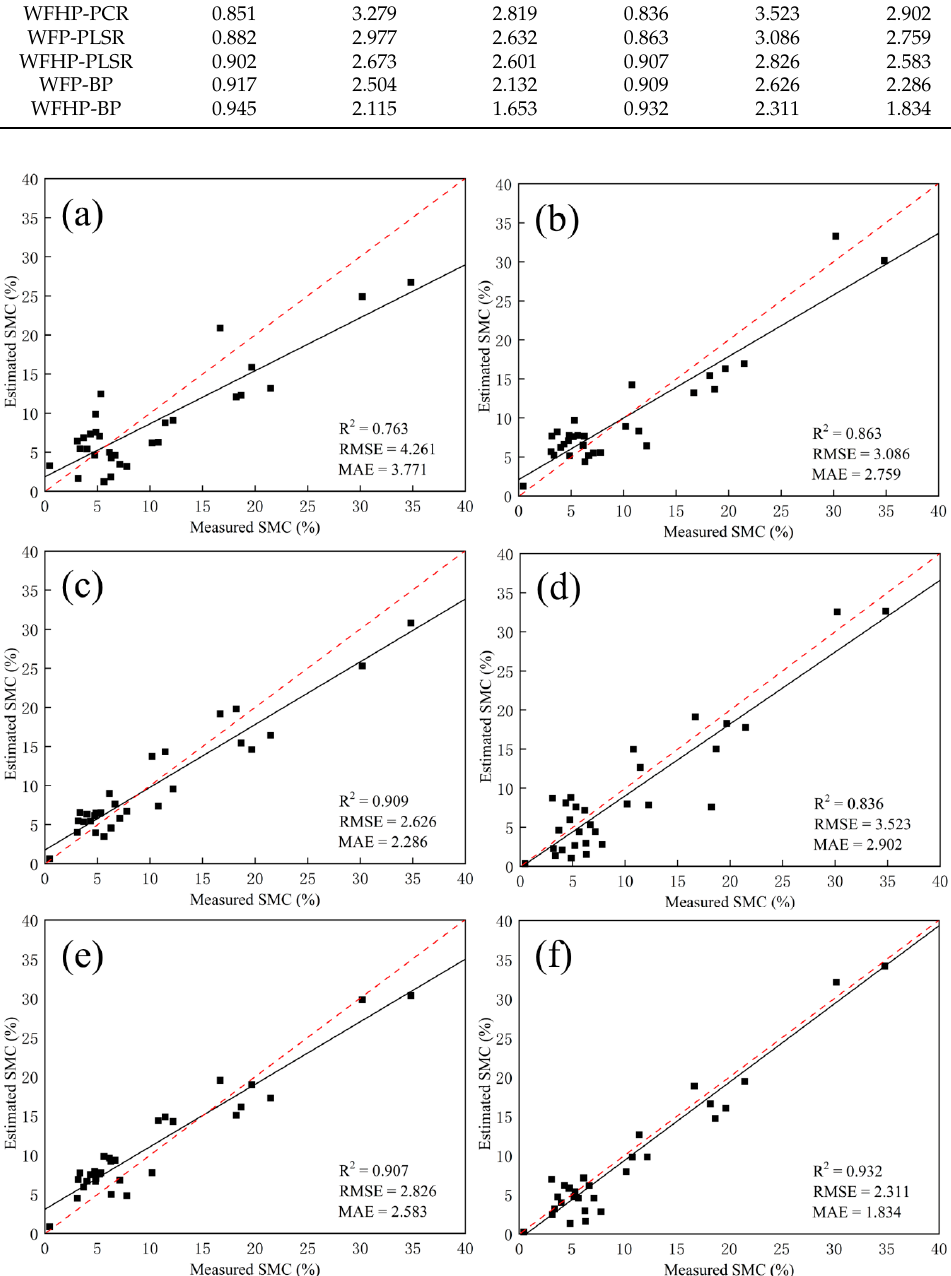
Figure 8. The comparison of measured and estimated SMC: ( a ) WFP-PCR; ( b ) WFP-PLSR; ( c ) WFP-BP; ( d ) WFHP-PCR; ( e ) WFHP-PLSR; ( f ) WFHP-BP.